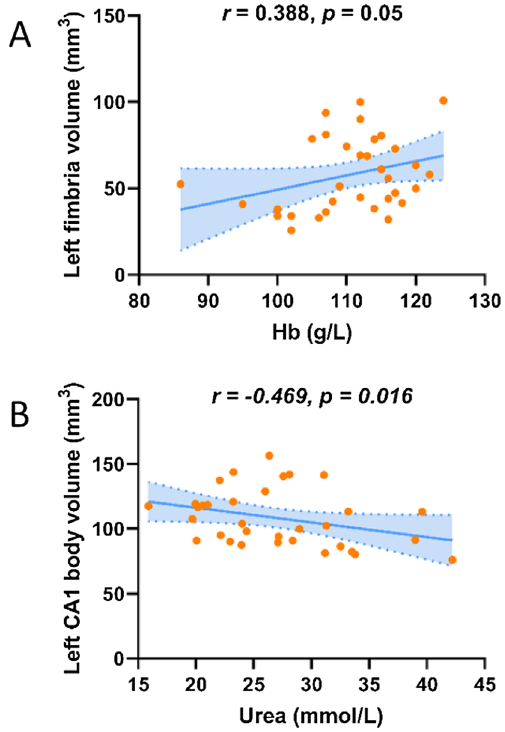
Figure 4. ( A ) Hb ( r = 0.388, p = 0.05) was positively correlated with the volume of the left fimbria. ( B ) Urea was negatively correlated with the left CA body volume ( r = − 0.469, p = 0.016). Adjusted age, gender, education, eTIV and hypertension and diabetes history. Hb hemoglobin, Urea serum